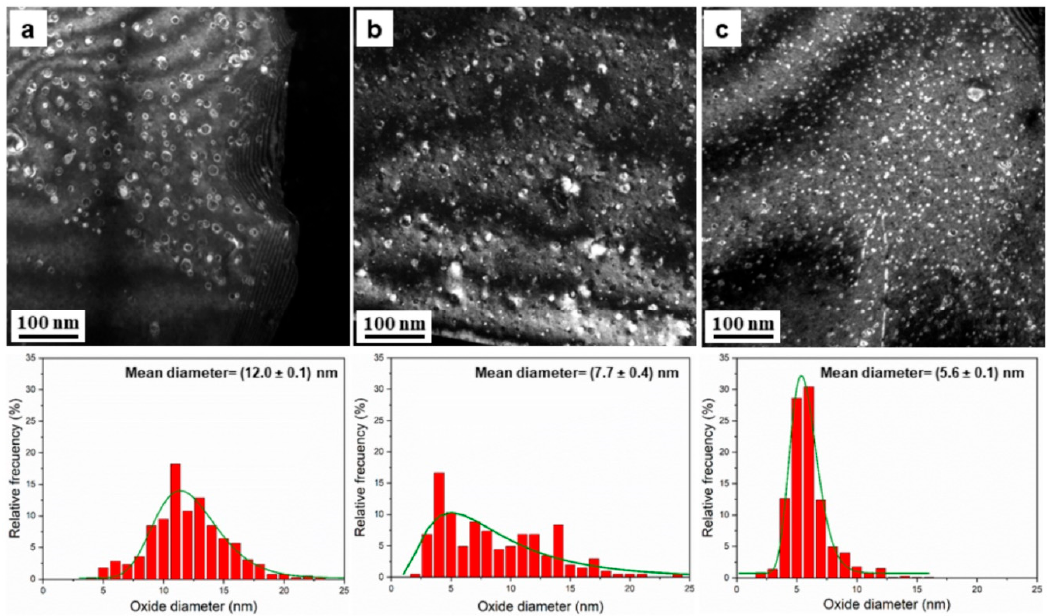
Figure 4. TEM images and oxide size distribution: ( a ) ODS-NoZr, ( b ) ODS-0.45Zr, ( c ) ODS-0.60Zr.